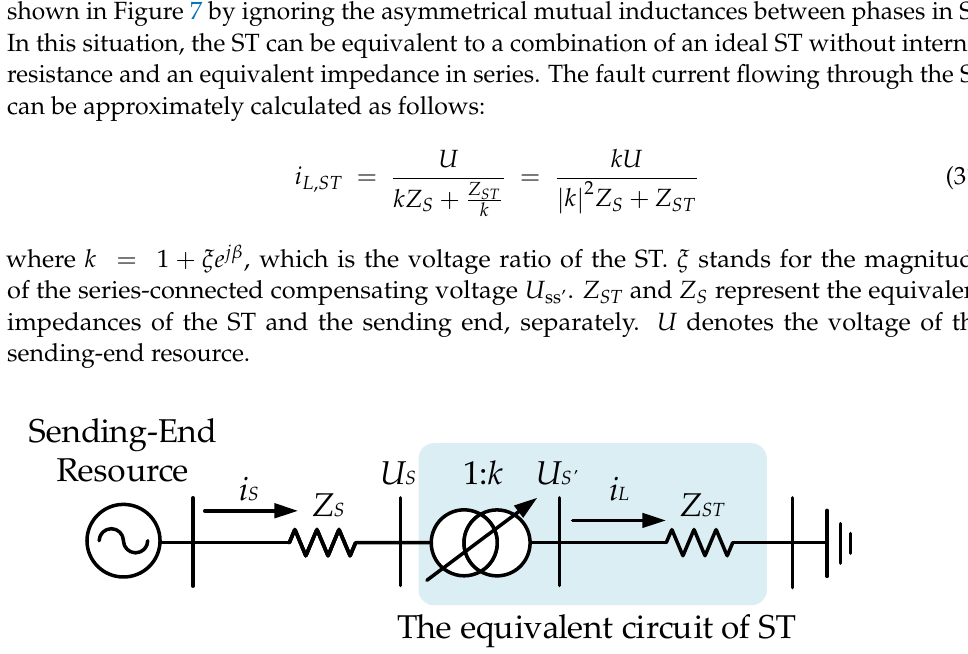
Figure 7. The equivalent circuit after a three-phase-to-ground fault. It can be seen from Equation (31) that the magnitude of the short-circuit current is mainly affected by 1/ | k | if Z ST is considered to be 0. The variation of 1/ | k | with the compensation phase angle is shown in Figure 8.